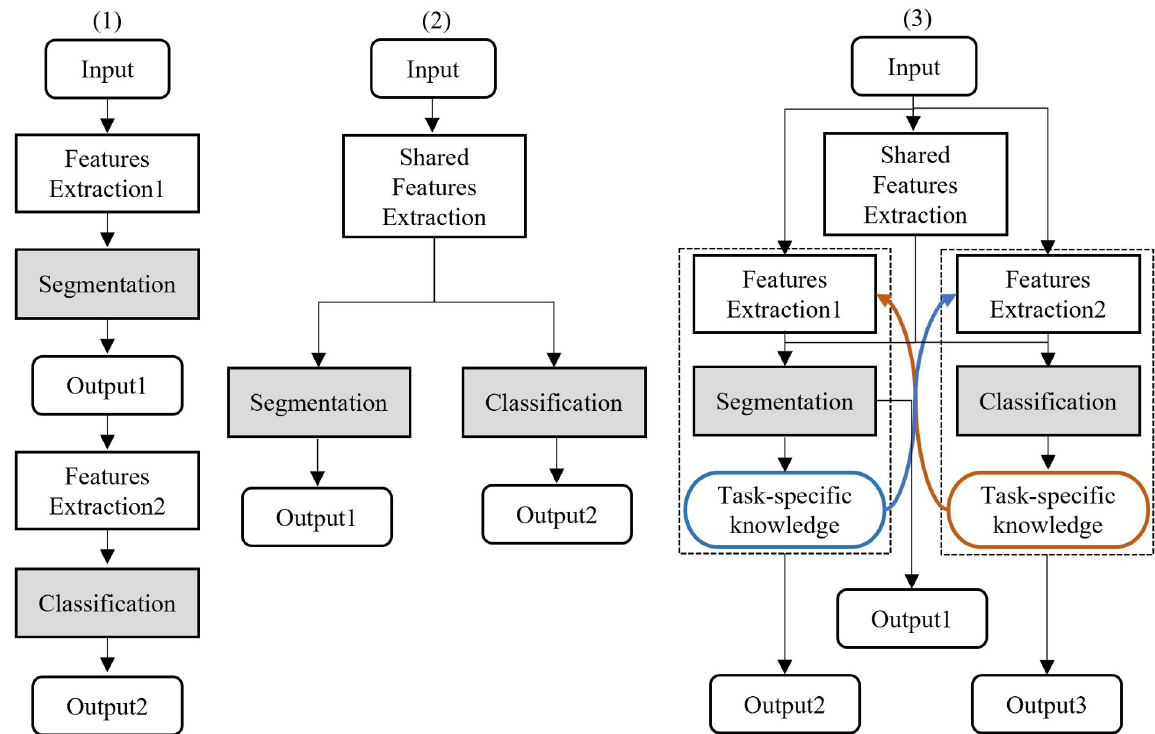
Fig 2. Illustration of the approaches used for performing BUS image segmentation and classification jointly. (1) Cascade approach; (2) Multi-task learning approach; (3) Cross-task approach.